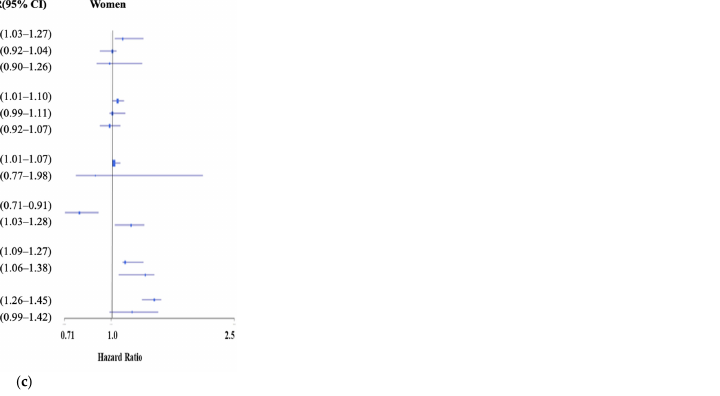
Figure 2. Subgroup analysis of the KoGES_HEXA among total ( a ), men ( b ), and women ( c ) by smok- ing, drinking, physical activity, BMI, age, and menopausal status (only for women) for gastric dis- ease (gastritis, gastric ulcer, and duodenal ulcer) risk. HRs, hazard ratios; 95% CIs, 95% confidence intervals. As shown in Table S2, the highest quartile of the E-DII in postmenopausal females showed a significantly increased risk of gastritis, gastric ulcers, and gastric and duodenal ulcers compared to the lowest quartile. Premenopausal females showed no significant as- sociation between the E-DII and gastric disease. Table S3 shows that study subjects over 65 years of age reported a significant association with incident gastritis (HR quartile4vs1 = 1.07; 95% CI = 1.03–1.24; p -trend = 0.01), gastric ulcers (HR quartile4vs1 = 1.21; 95% CI = 1.07–1.34; p - trend = 0.01), and gastric and duodenal ulcers (HR quartile4vs1 = 1.10; 95% CI = 1.02–1.09; p - trend = 0.01). As shown in Figure 3, a significant dose–response association was observed for gas- tric ulcers and gastric and duodenal ulcers in the total cohort ( p > 0.05). No significant results were found for gastritis or gastric disease.